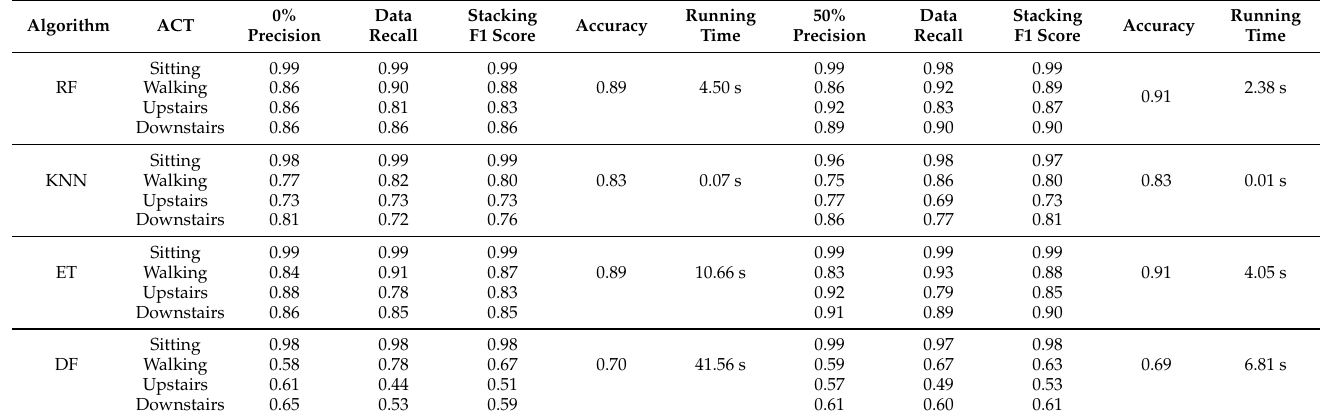
Table 7. Algorithms’ evaluation metrics for activity